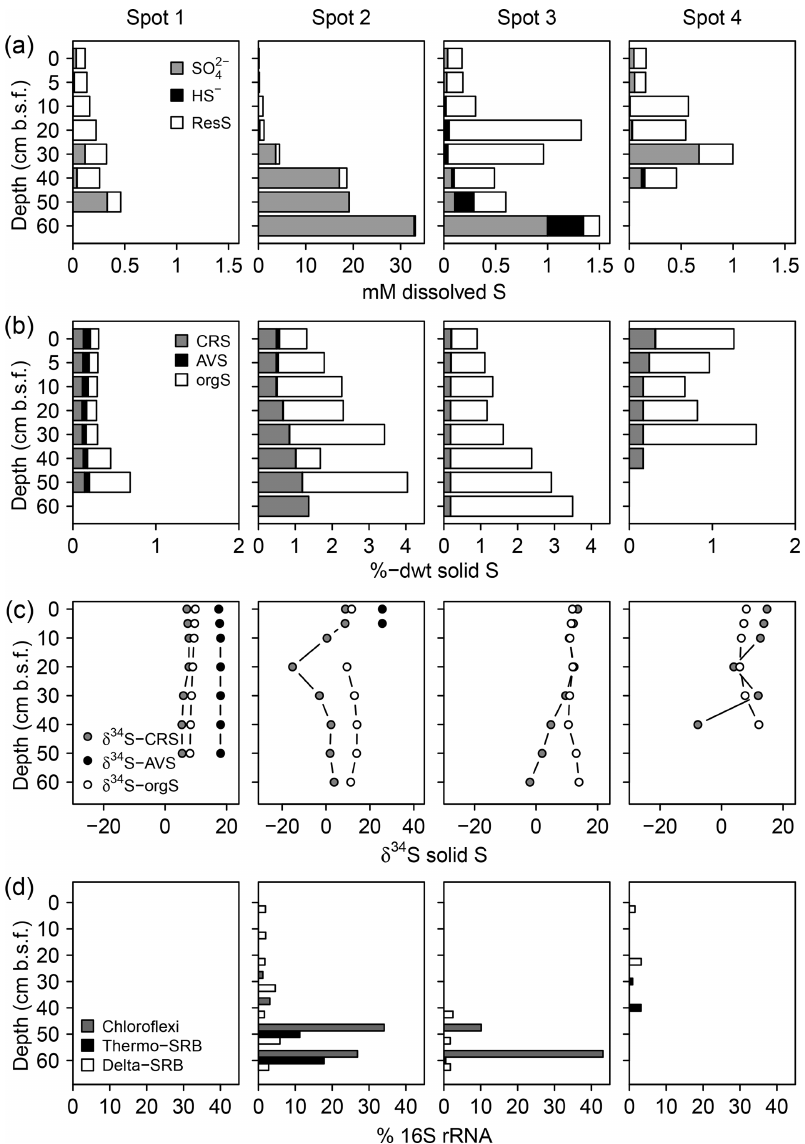
Figure 4. Speciation of dissolved (a) and solid (b) S compounds, S isotope composition of solid S compounds (c) , and average relative abundances of sulfate-reducing bacteria (SRB, d ). δ 34 S and δ 18 O ratios of SO 2 − are displayed in Fig. 6a. The residual dissolved S (ResS 4 in a ) refers to a non-specified S fraction resulting from the difference between total dissolved S, H 2 S, and SO 2 − . ResS is most likely 4 composed of dissolved organic S, polysulfides, and S intermediates. Solid S fractions (b) include iron monosulfide operationally defined as acid volatile sulfur (AVS), pyrite extracted as chromium-reducible sulfur (CRS), and a residual fraction suggested to consist primarily of organic S (orgS). δ 34 S at AVS could only be measured at spot 1 and the top of spot 2. SRB were extracted from two replicates of the 16S rRNA bacterial community sequencing and are assigned to the Deltaproteobacteria (Delta-SRB) and the Nitrospirae phyla (genus Thermodesulfovibrionaceae – Thermo-SRB). Chloroflexi Dehalococcoides (Chloroflexi) have not been assigned to SRB in the classical sense; however, they could be potentially involved in S metabolism (Wasmund et al., 2016). Note the different x axis